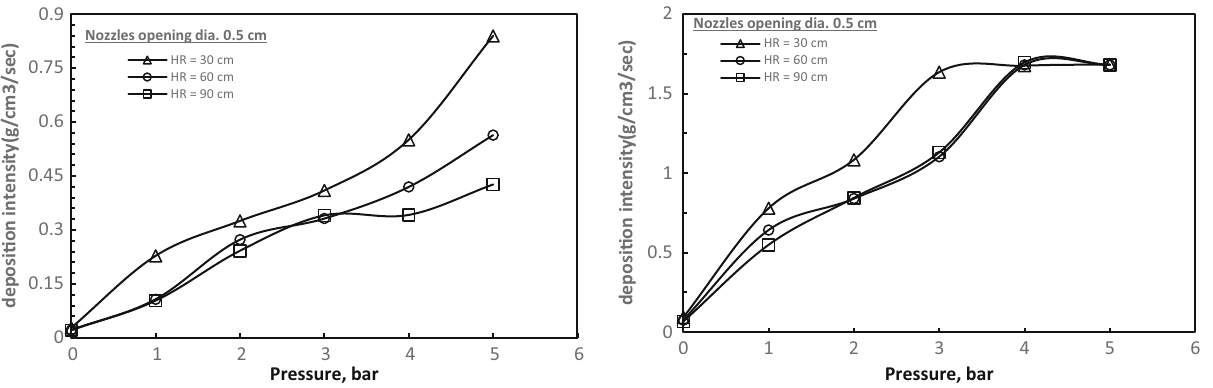
Figure 8: Variation of DI, TAP, and HF for nozzle size of 0.5 cm. Figure 10: Variation of DI, TAP, and HF for nozzle size of 2.0 cm.